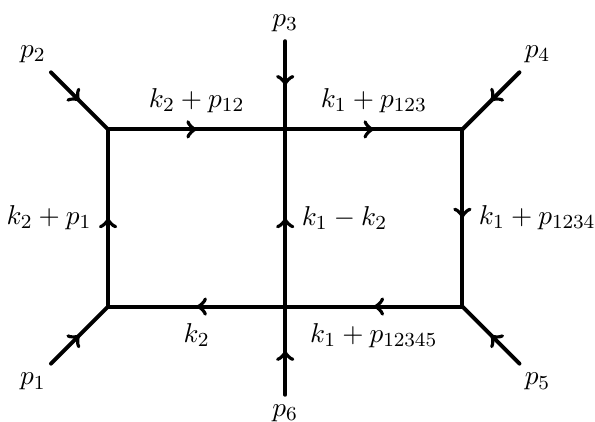
Figure 2 . Double-box integral in momentum space. Incoming momenta are assumed to be off- shell, i.e. p 2 + · · · + p . The internal propagators are 6 = 0 , and p i ≡ p i i n i 1 ··· i n 1